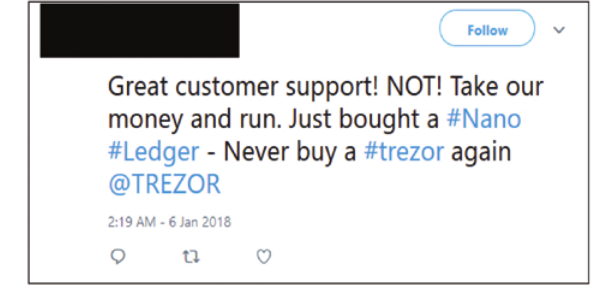
Figure 1: A sample tweet.